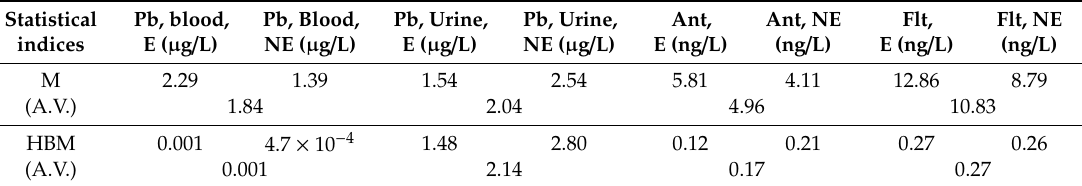
Table 11. Ratio (%) between the contaminant concentration in blood or urine due to the air route only and total concentration estimated by MERLIN (M) or total concentration measured in the Bio-monitoring study (HBM). E = exposed, NE = non exposed. A.V. = average value. Pb = Lead, Ant = Anthracene,